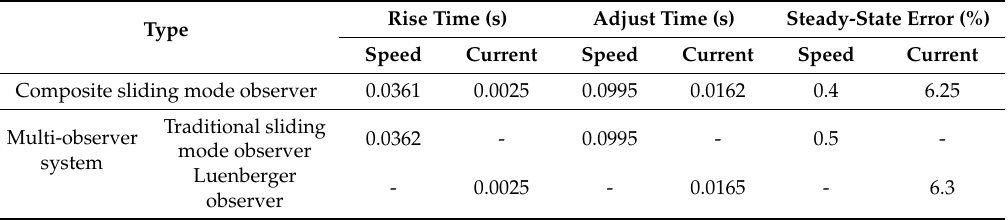
Figure 11. The estimation error waveforms of observation signals of two types of system under normal operating conditions. ( a ) The speed estimation error based on composite sliding mode observer; ( b ) The speed estimation error based on Luenberger observer (multi-observer system); ( c ) The current estimation error based on composite sliding mode observer; ( d ) The current estimation error based on traditional sliding mode observer (multi-observer system). Table 2. The dynamic and steady-state performance indexes based on different observers.